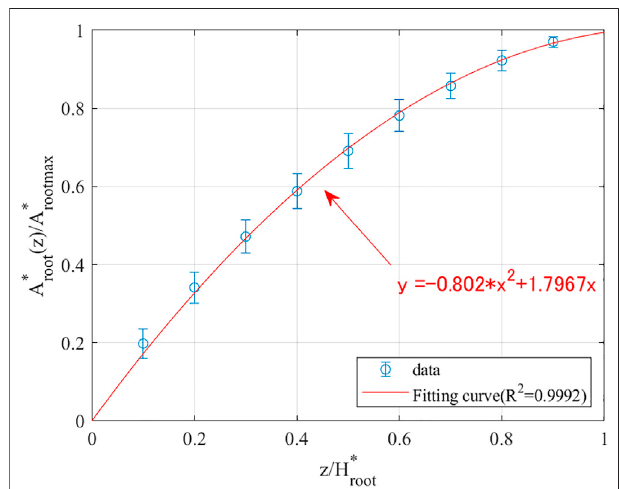
FIGURE 5 | Relationship between the normalized projected area of the root system A root and the normalized distance z from the ground (circle: measured data, solid line: regression curve) ( Rhizophora stylosa